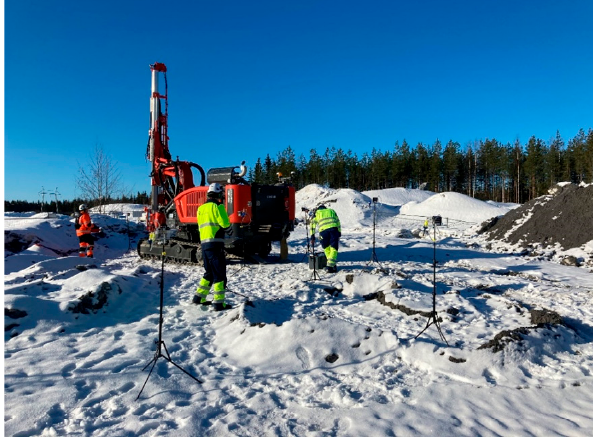
Figure 5. Measuring quartz dust emissions of a drilling rig in a test field. Reproduced with permission from Tuomi et al., Finnish Institute of Occupational Health, 2022 [34].